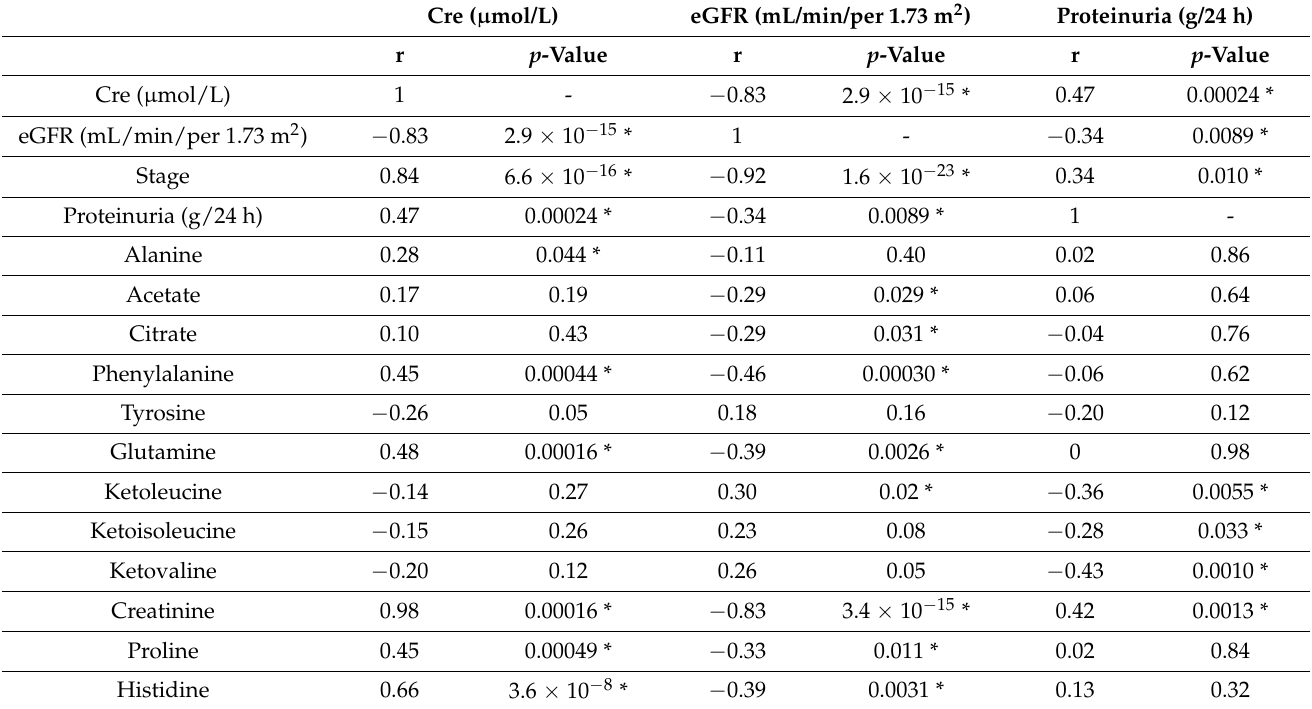
Table 3. Pearson’s correlations of serum creatinine (Cre), eGFR, and proteinuria with relative metabo- lites level in blood plasma, determined by NMR spectroscopy, as well as the interrelationships among patients’ parameters, * significant correlation. Cre ( µ mol/L) eGFR (mL/min/per 1.73 m 2